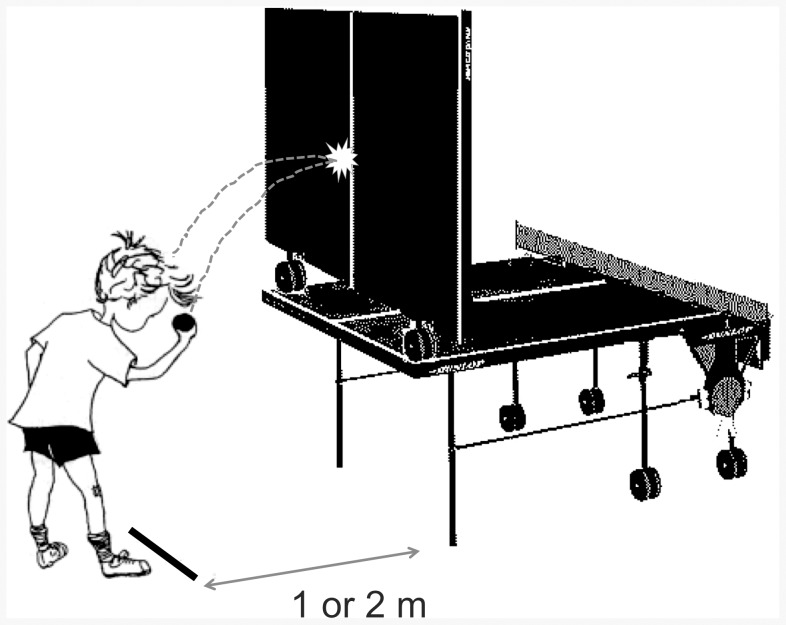
Eye-hand coordination test set-up.